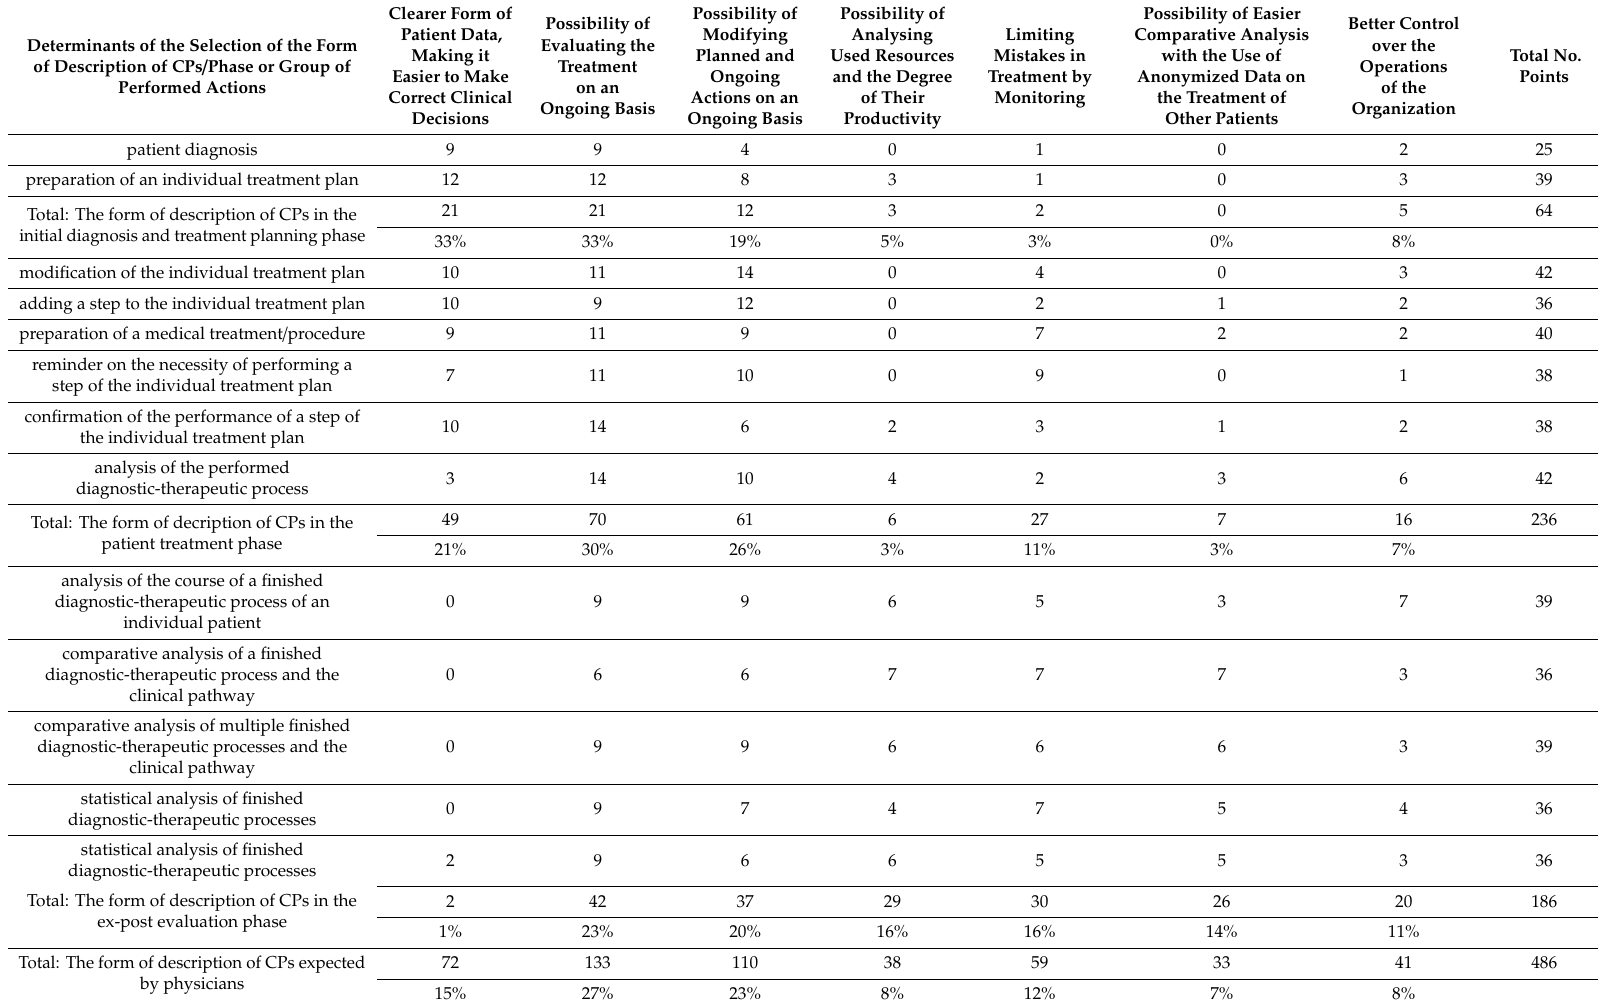
Table 3. Determinants of the choice of the form of description of CPs preferred by